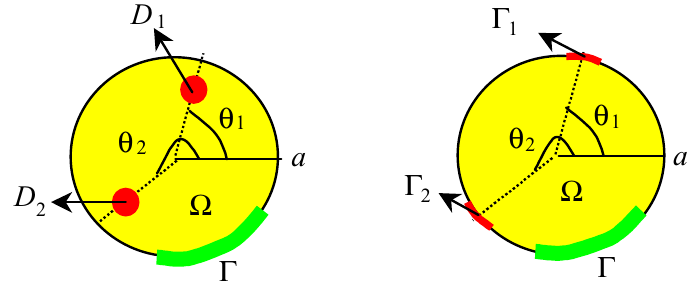
Figure 7. Disc domain, region Γ and locations